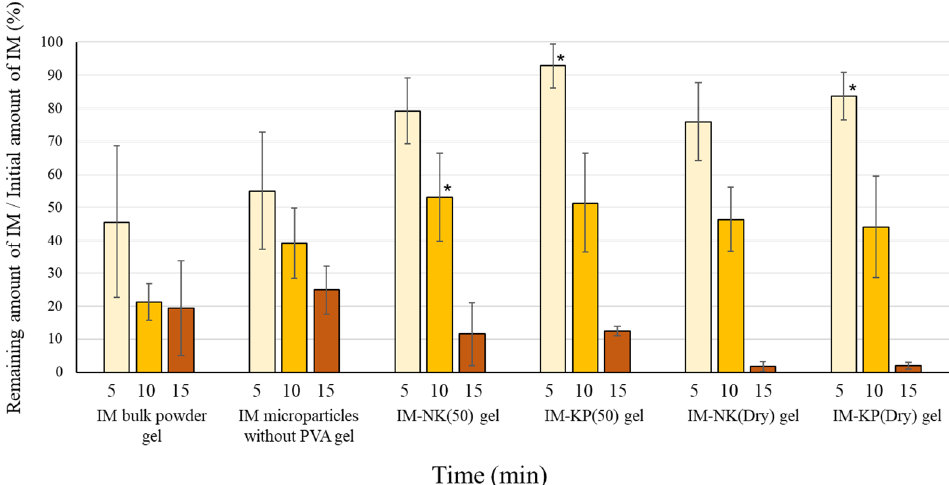
Figure 9. Drug Retention Ratio After Application of the Gel Preparations to the Mucin Disks. Each Value Represents the Mean ± SD ( n = 3). * p < 0.05; Dunnett’s Test Was Performed. IM Microparticle Gels > IM Bulk Powder Gel.